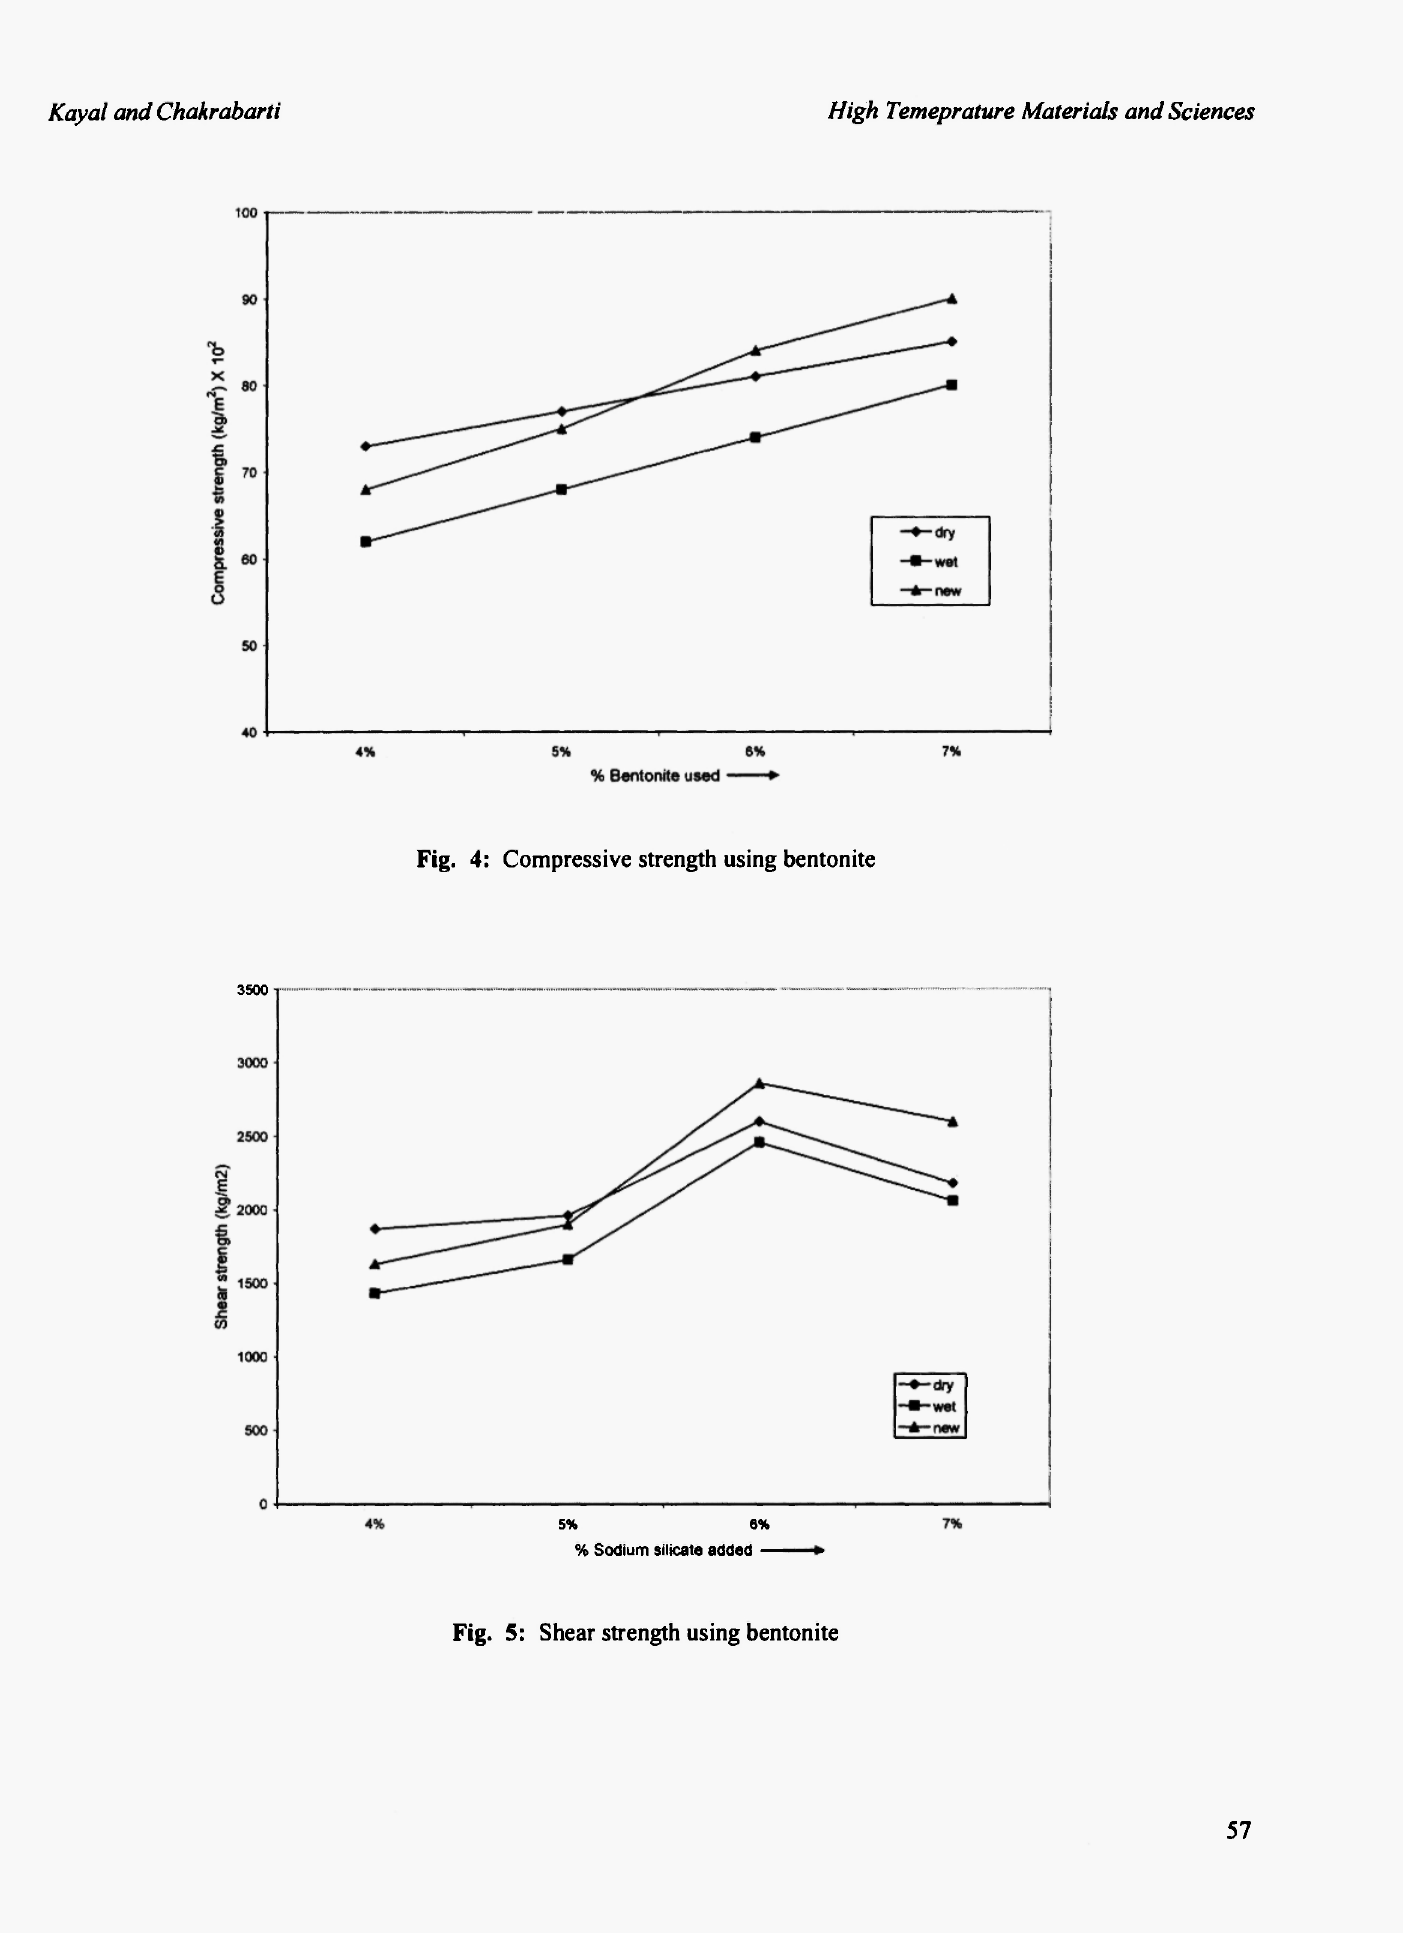
Fig. 5: Shear strength using